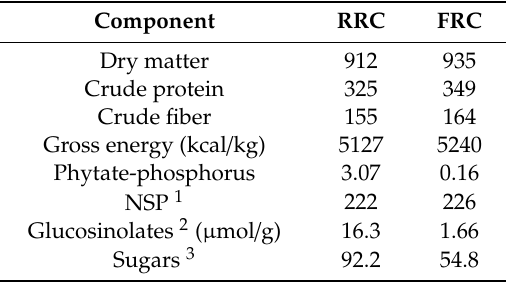
Table 2. Chemical composition of raw rapeseed cake (RRC) and fermented rapeseed cake (FRC) (g / kg, dry matter basis).